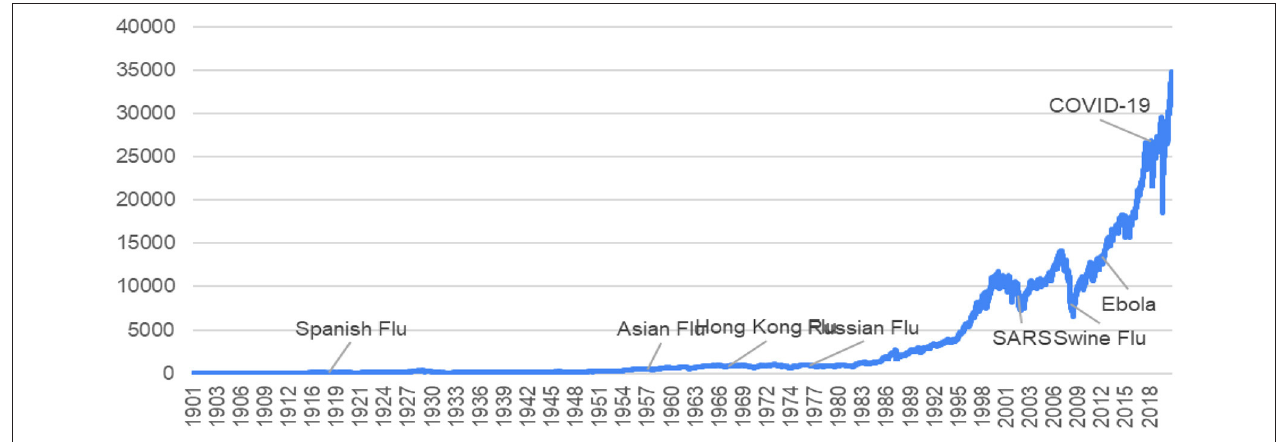
FIGURE 1 | World pandemics and the movement of the Dow Jones Industrial Average (DJIA).